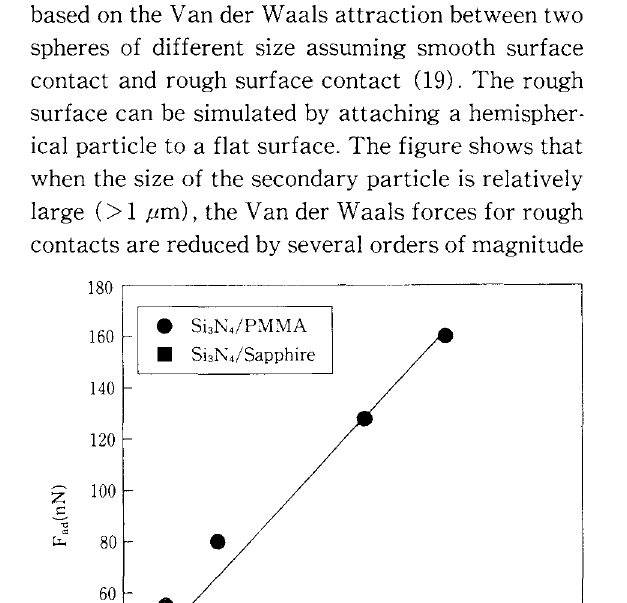
Fig. 10 The adhesion force between the AFM tip and PM:'v!A and sapphire substrates as a function of loading. The loading leads to plastic deformation of the P:'v1:\1A substrate while no plastic deformation in sapphire